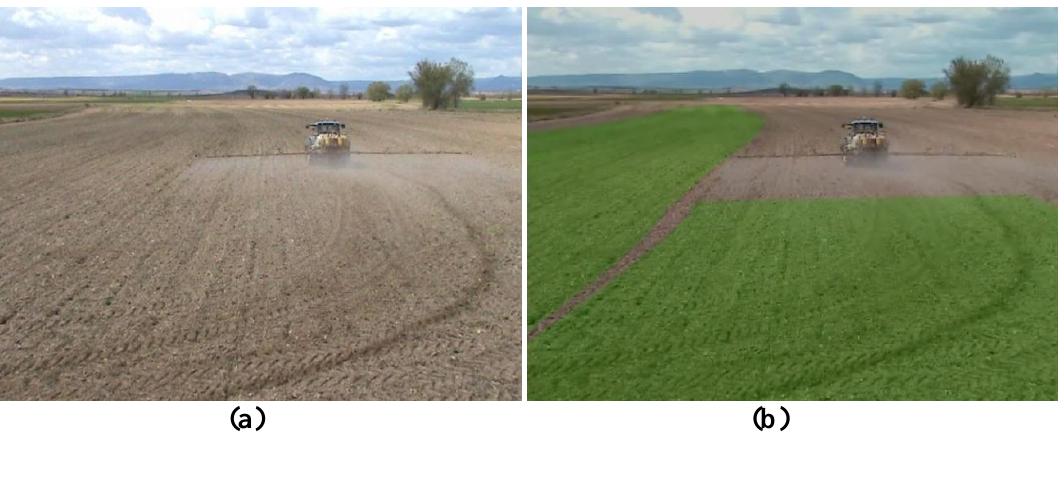
Figure 10. Another possible scene that an observer sees: ( a ) without the use of the developed system or ( b ) with the use of the developed augmented reality